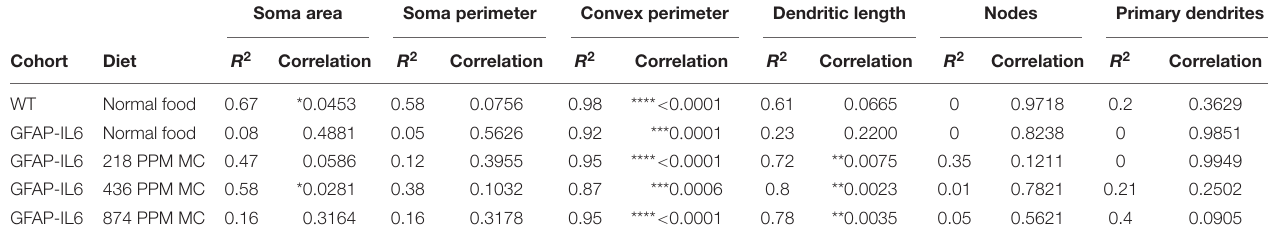
TABLE 4 | Bivariate correlation of morphological characteristics with overall microglial cell size in the hippocampus. Soma area Soma perimeter Convex perimeter Dendritic length Nodes Primary dendrites